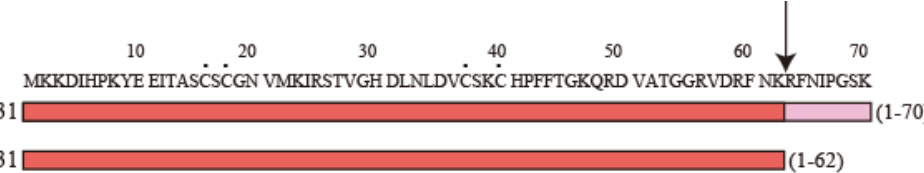
Figure 2. Amino acid sequences of intact and short bL31s. The amino acid sequence of intact bL31 (70 amino acids) (P0A7M9 · RL31_ECOLI, Uni Prot) is shown at the top, with amino acids 1–62 and 63–70 shown in red and pink, respectively. Short bL31 (62 amino acids), shown in red at the bottom, is produced via the cleavage of intact bL31 by protease 7. The arrow and black dots indicate the site cleaved by protease 7 and cysteine residues, respectively. In Figure 2, the “b” of r-proteins is omit- ted.